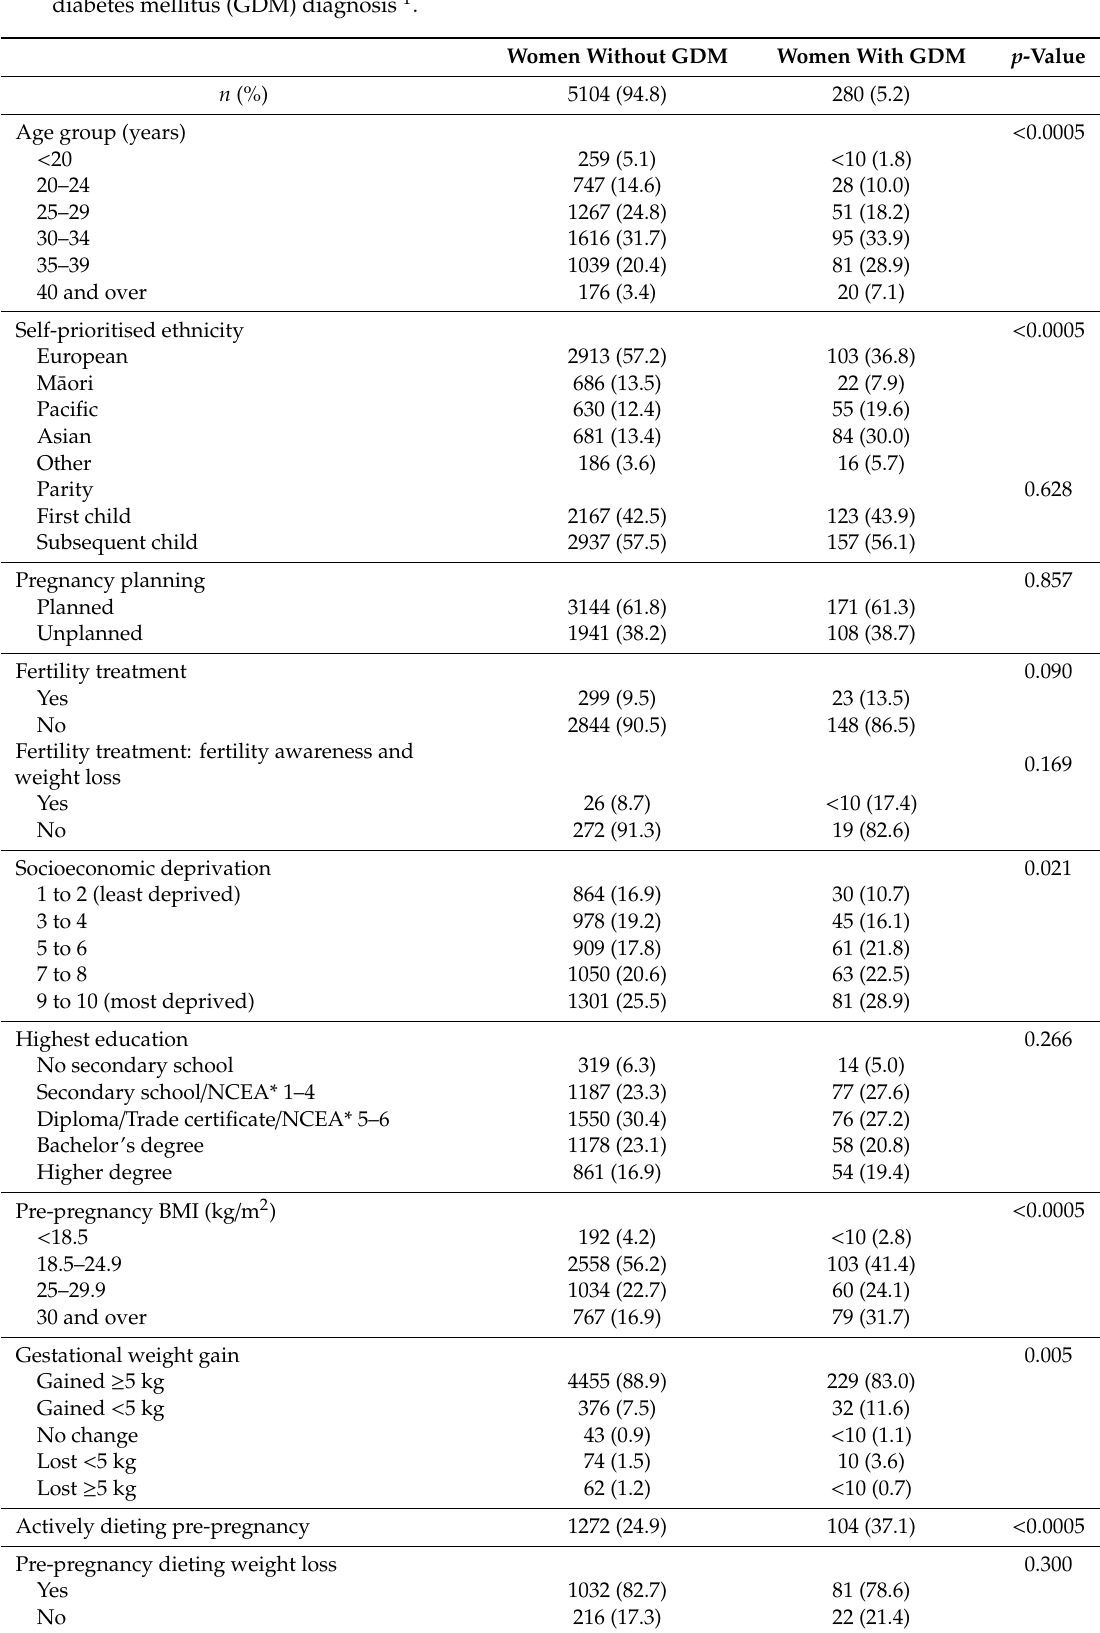
Table 1. Characteristics of women in the Growing Up in New Zealand cohort according to gestational diabetes mellitus (GDM) diagnosis 1